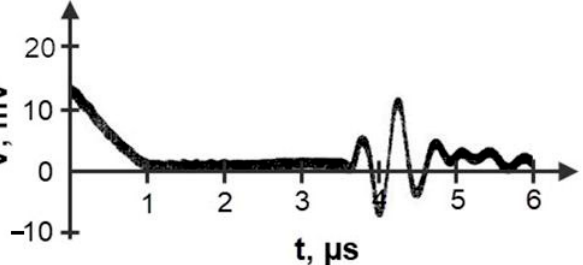
Figure 9. Typical piezoelectric response of the ZnO film measured with acoustic probe from Figure 2.